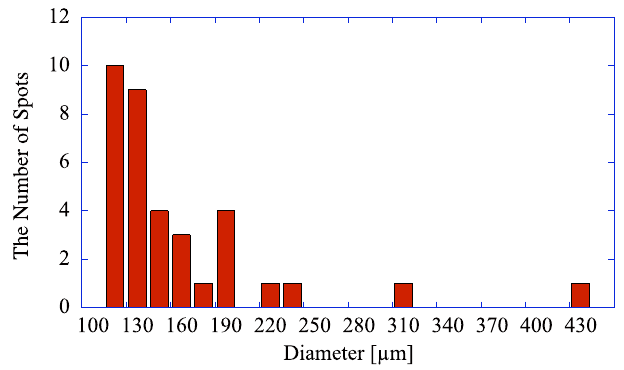
FIG. 5. (Color) Population of diameter from Z84 observation.